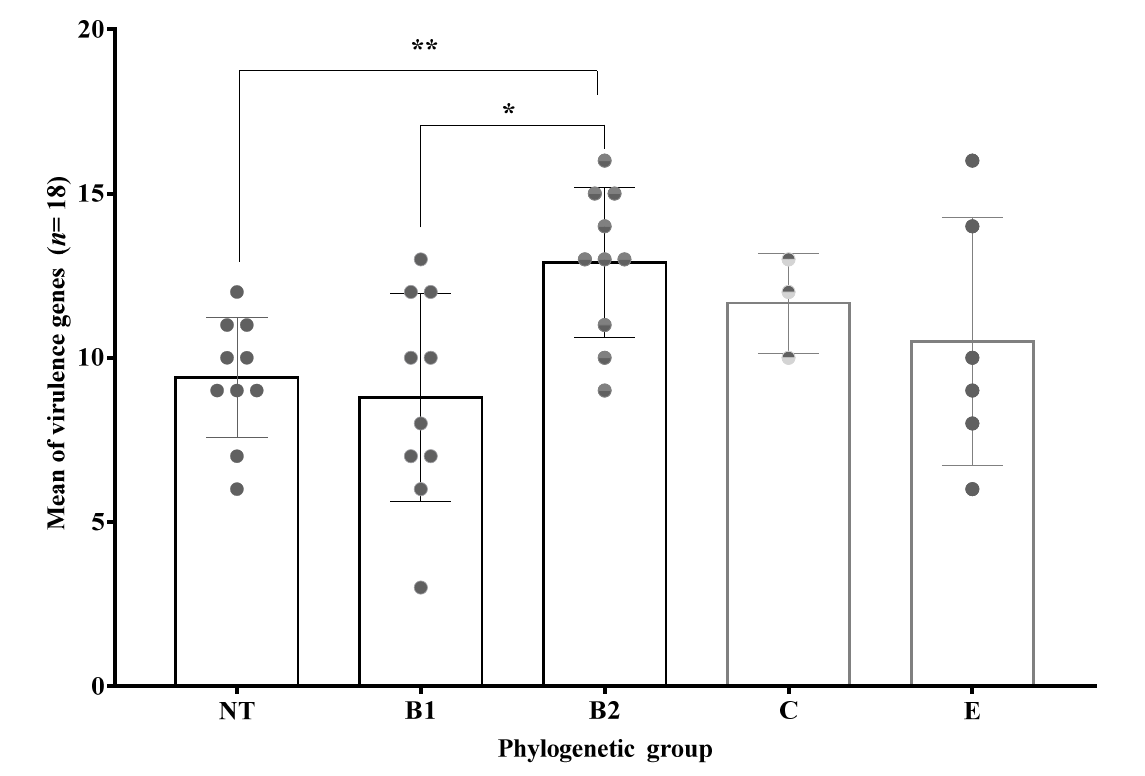
Figure 6. Mean of virulence by phylogenetic groups. **: p = 0.01; *: p = 0.04. One way ANOVA Tukey’s multiple comparisons test. Error bars show standard deviation (SD) and each gray dot represent clinical isolates of specific phylogenetic group. Table 5. Virulence genes distribution between phylogenetic groups of UPEC clinical isolates.